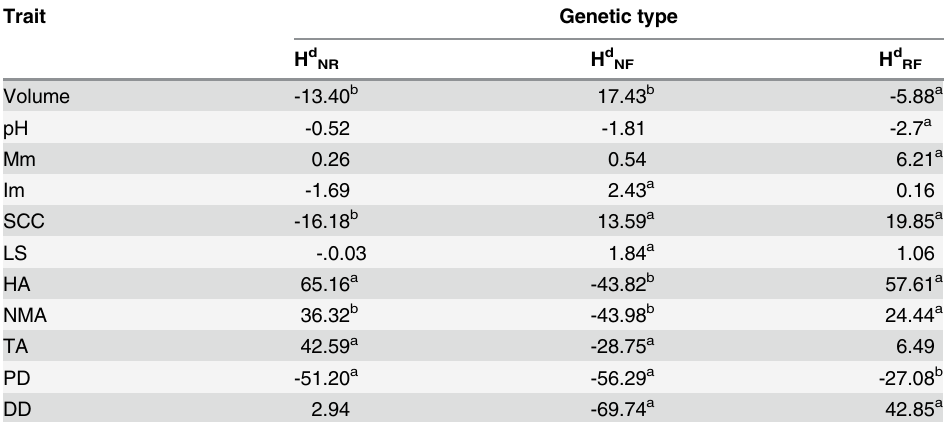
Table 3. Heterosis percentages of semen quality traits for the crossbred male rabbits